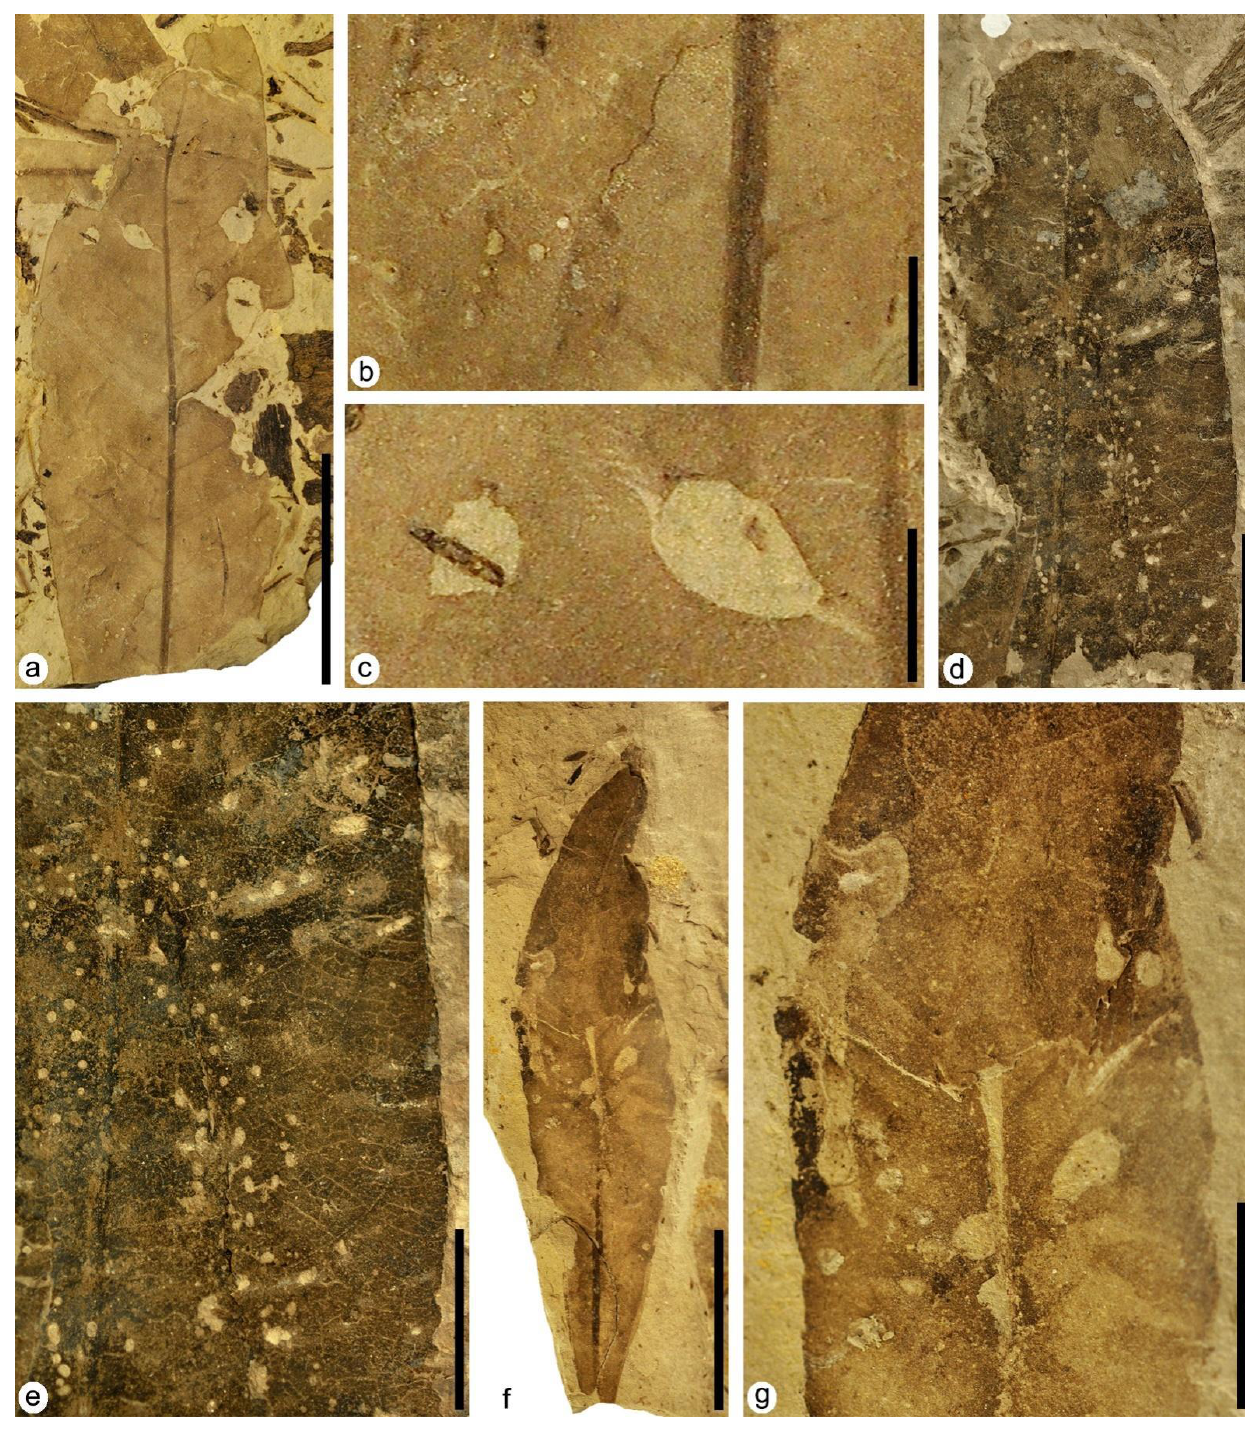
Figure 5. Plant – insect interactions on leaves of the terrestrial Angiosperm Type 1. ( a ) MAP-8359, apical part of a leaf with hole feeding DT01 and DT03 and margin feeding DT15. ( b ) Detail of small holes of hole feeding DT01 in photo ( a ). ( c ) Detail of big holes of hole feeding DT03 in photo ( a ). ( d ) MAP-8360, apical part of a leaf with hole feeding DT01. ( e ) Detail of small holes in photo ( d ). ( f ) MAP-8361, nearly complete leaf with hole feeding DT02 and DT03. ( g ) Detail of hole feeding DT02 and DT03 in photo ( f ). Scale bars: ( a , d , f ) = 2 cm; ( e , g ) = 1 cm; ( b , c ) = 5